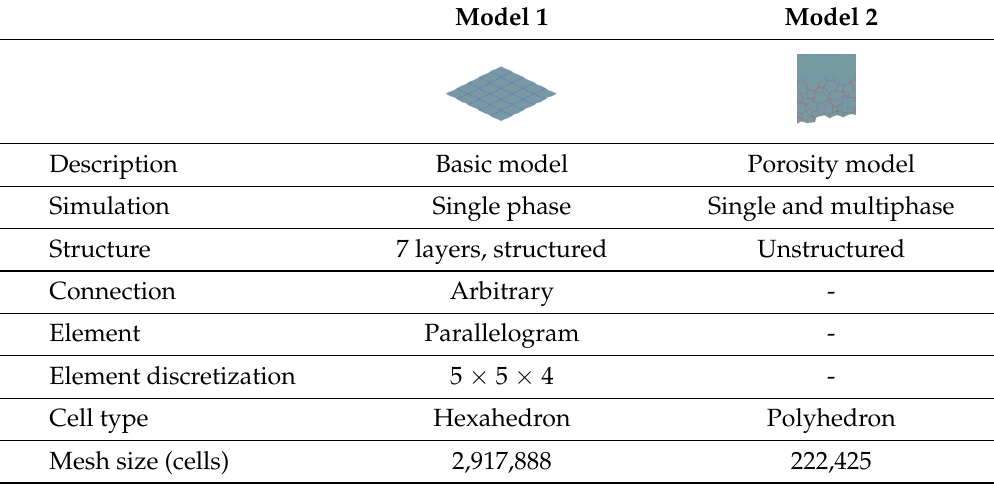
Table 2. Summary of the geometrical models.